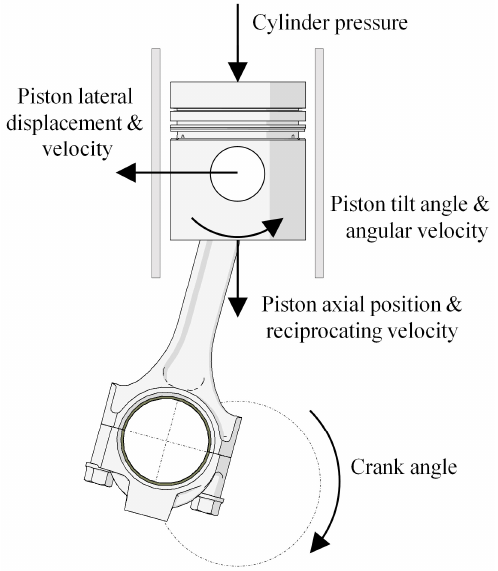
Figure 3. Subroutine’s measurements not related to the deformation for the multibody dynamics model of the piston–liner interaction.